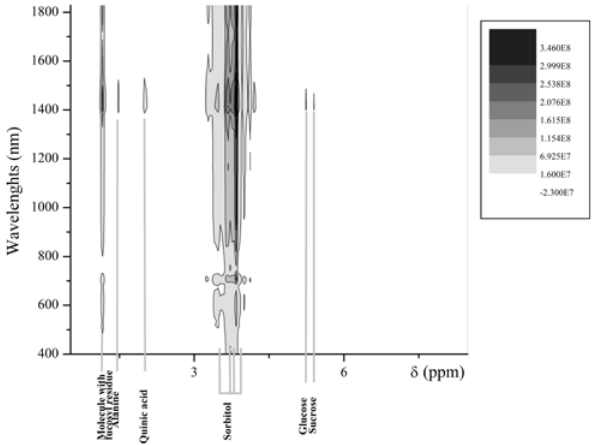
Figure 8. Contour plot resulting from the HR-NMR covari- ance analysis applied data for pear leaf samples from con- trol, Ea and Pss treatments. Samples harvested at 20 dpi.